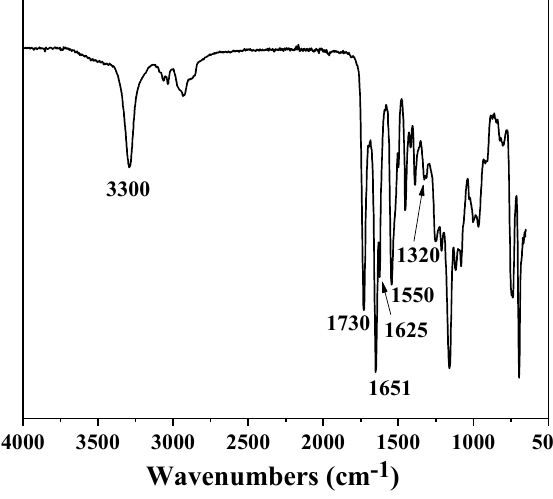
Figure 3. Fourier transform infrared (FTIR) spectrum of PBLG-PPG-PBLG.